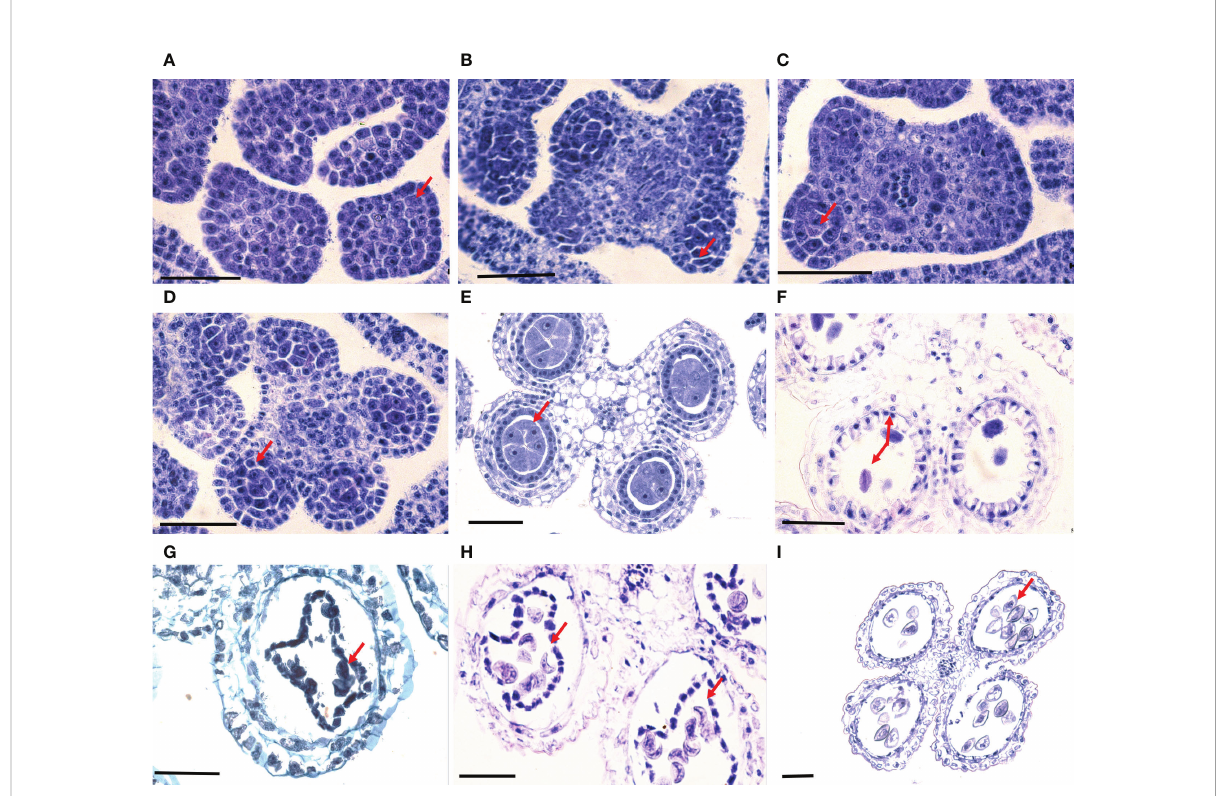
FIGURE 2 Normal development of microsporocytes yet anther abortion of B. oldhamii ‘ Xia Zao ’ . (A) Undifferentiated anther. (B) Archesporial cell divided periclinally to produce one primary parietal cell and one primary sporogenous cell. (C) Primary sporogenous cell and anther wall with two layers. (D) Secondary sporogenous cells and anther wall with three layers. (E) Microspore mother cells and anther wall with four layers. (F) Diad, showing more dense cytoplasm, abnormal spindle fi ber and unformed equatorial plate. (G) Deformed tapetum and abnormal tetrad. (H) Most uninucleate microspores shrank and deformed abnormally. (I) Deformed 2-cell pollen grains and the residual tapetum. Bar = 50 m